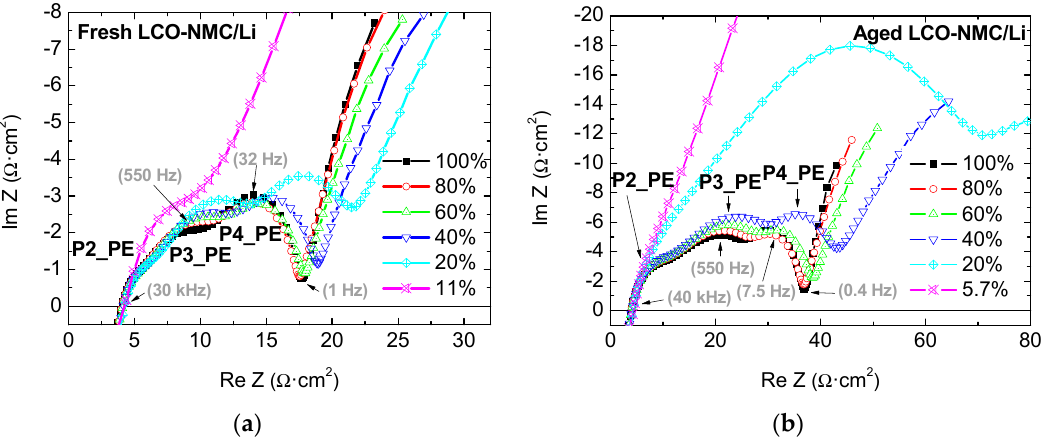
Figure 4. Impedance variation during lithium insertion to the positive electrode for different states of charge (SoC) in the LiCoO 2 -Li(NiMnCo)O 2 /Li (LCO-NMC/Li) half-cell configuration. Measurements are carried out at 25 °C. ( a ) Data are from the fresh cell and ( b ) from the aged cell. Please note the different scales. Some frequencies are indicated with an arrow, which corresponds to a 100% SoC.